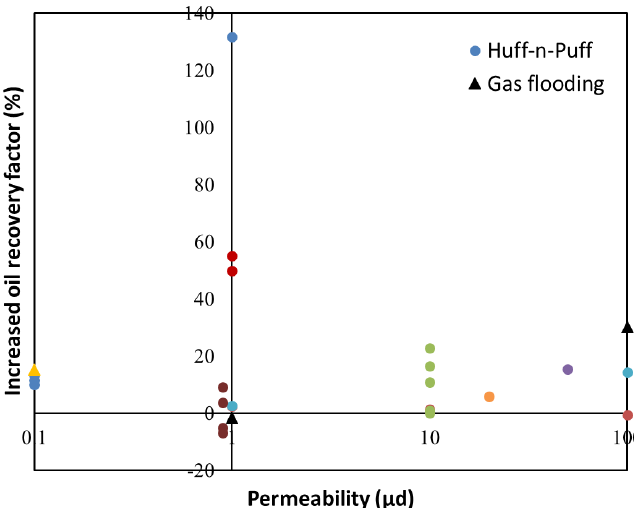
Figure 3. Incremental oil recovery factor of huff-n-puff and gas flooding from simulation studies (Table 2), for the range of matrix permeability from 0.1 to 100 µd. Different colors represent different simulation studies.